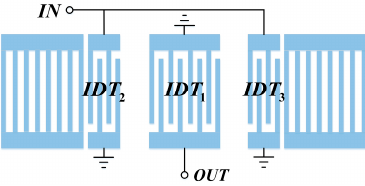
Figure 1. The schematic of a two-port R-SAW resonator with three IDTs.